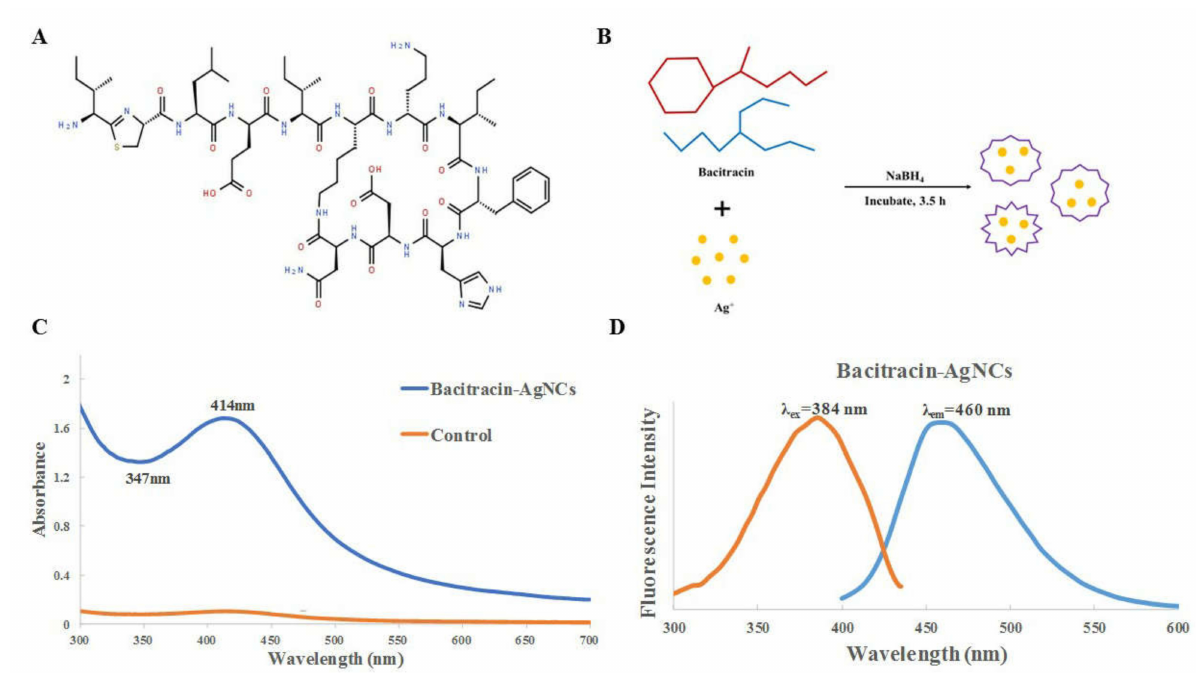
Figure 1. ( A ) Chemical structure of bacitracin. ( B ) Scheme for producing Bacitracin-AgNCs. ( C ) UV-VIS absorption spectra of Bacitracin-AgNCs. ( D ) Fluorescence spectra (excitation, emission) of